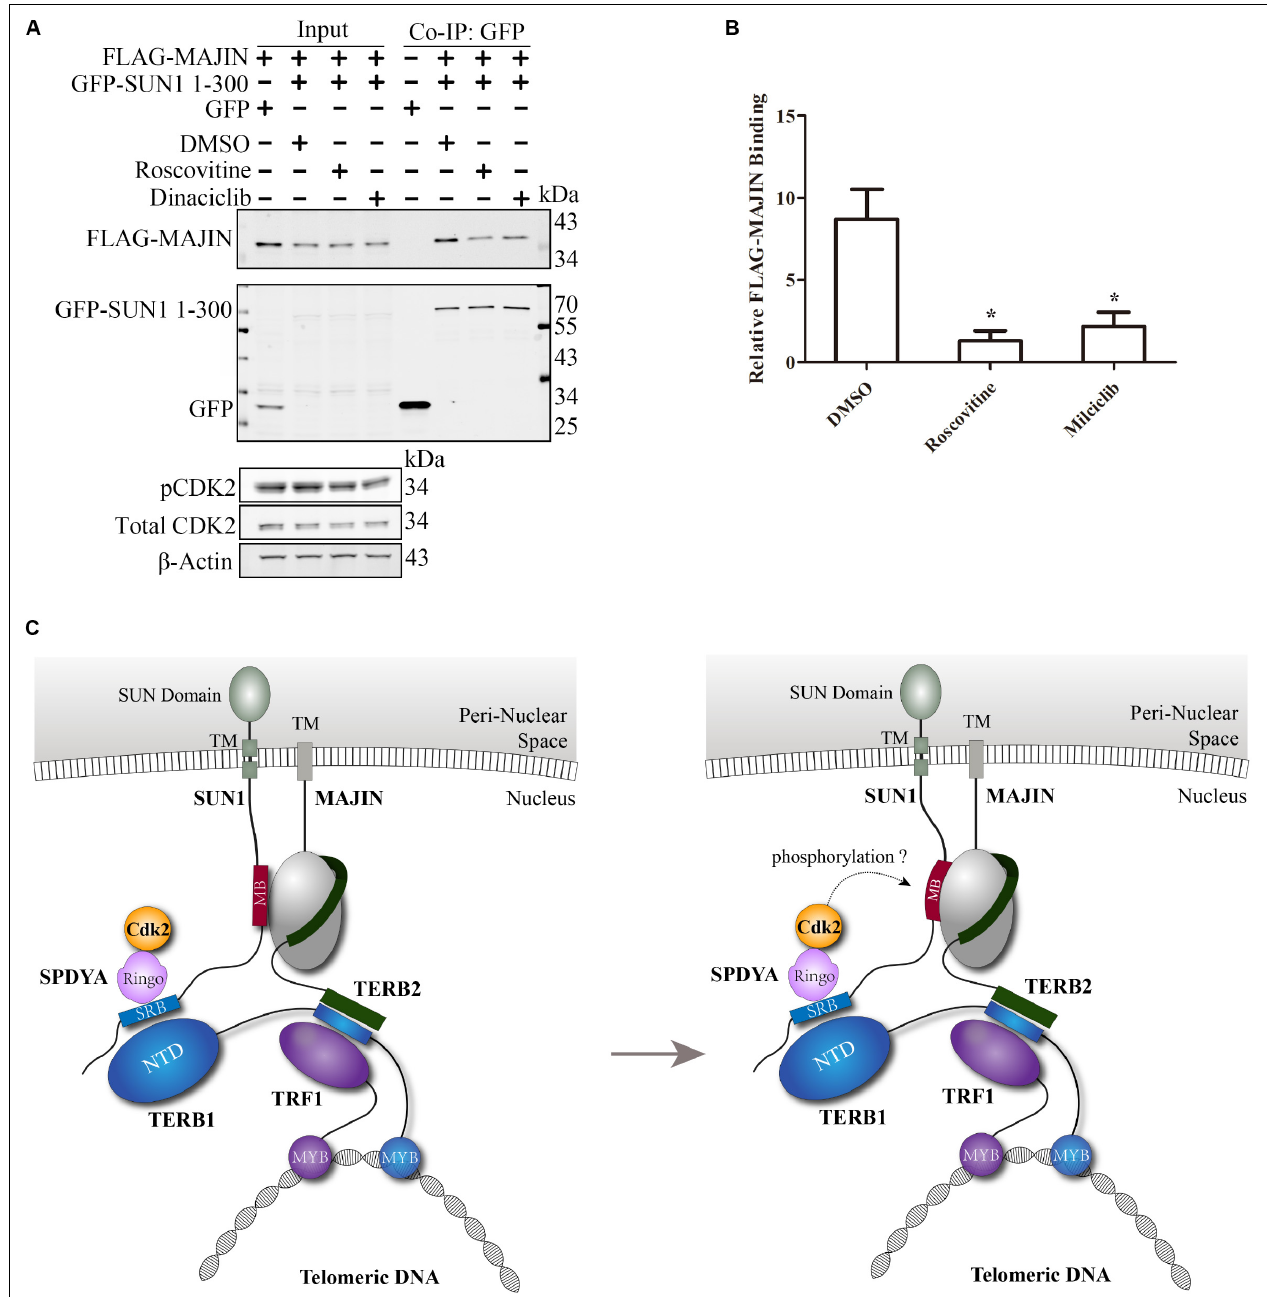
FIGURE 6 | The interaction of SUN1 with MAJIN is reduced by CDK2 inhibitors. (A) The SUN1-MAJIN interaction is decreased by CDK2 inhibitors. (B) The histogram shows FLAG-MAJIN binding in (A) , data are presented as mean ± SEM with three repeats. * P < 0.05. (C) Illustration of the interaction of SUN1 with MAJIN regulated by